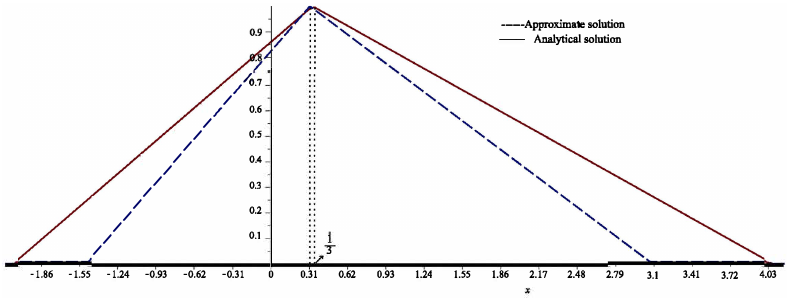
Figure 1. Approximate and analytical solutions of Example